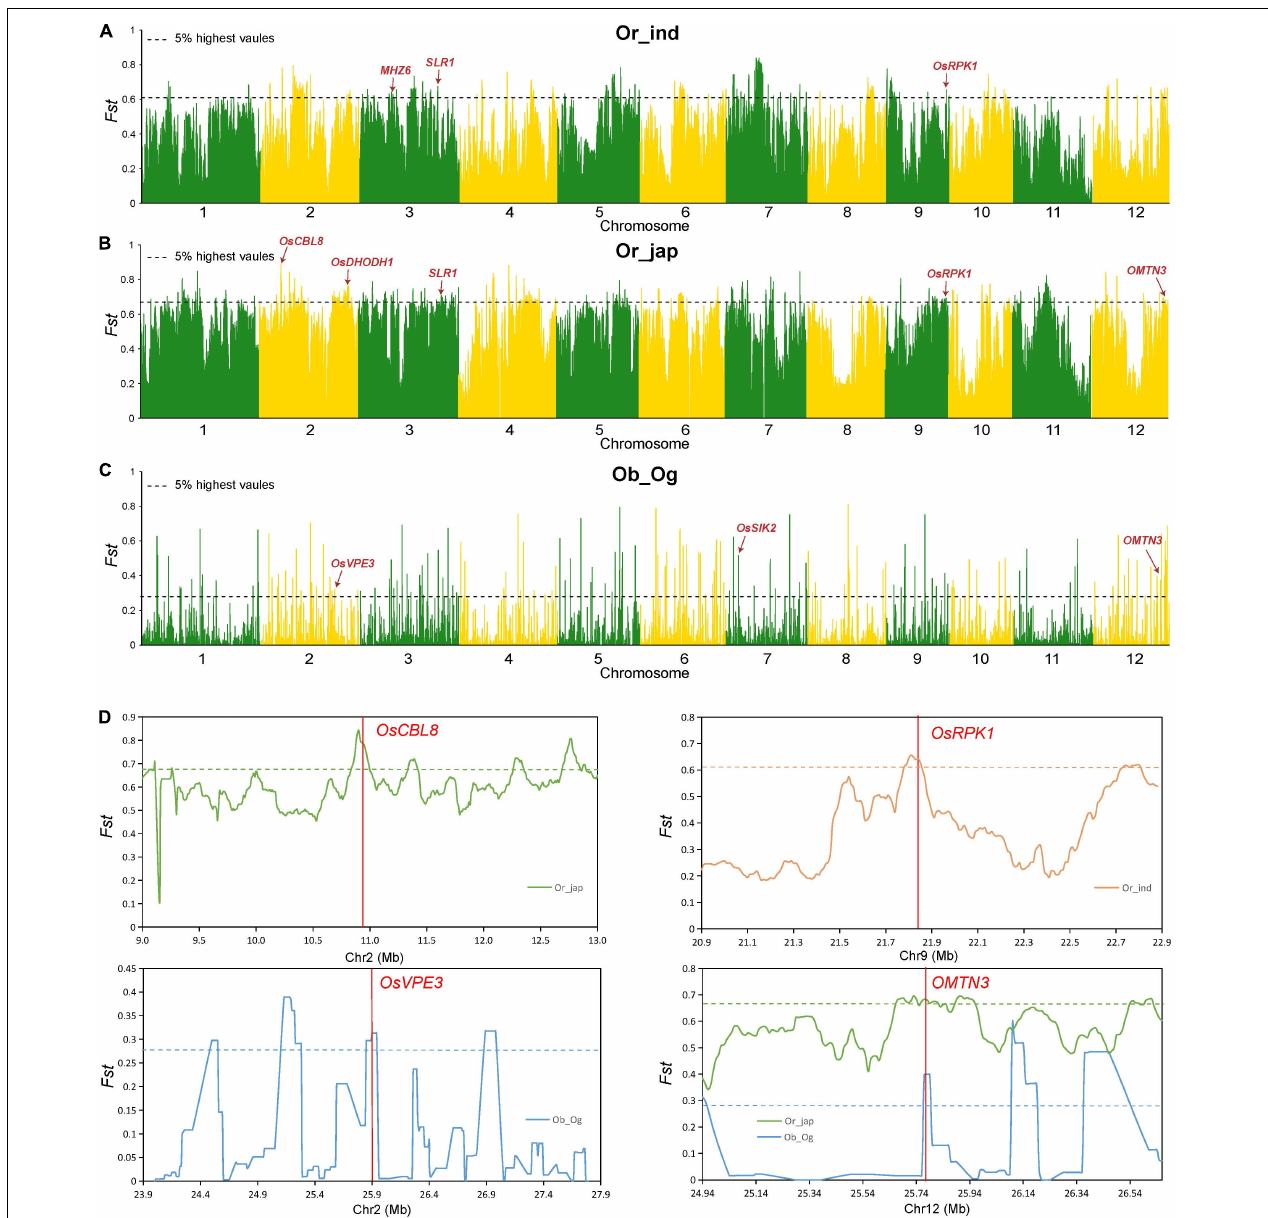
FIGURE 5 | Genomic differentiation statistics. (A–C) Genomic differentiation between O. rufipogon and indica (ind) (A) ; O. rufipogon (Or) and japonica (jap) (B) ; and O. barthii (Ob) and O. glaberrima (Og) (C) . Red arrows indicate the divergent regions overlapping with reported salt tolerance genes. (D) Genetic differentiation of several important genes. Green, orange, and blue lines represent the F ST between O. rufipogon and indica , O. rufipogon and japonica , and O. barthii and O. glaberrima , respectively. Horizontal dashed lines correspond to the top 5% threshold. Red vertical lines represent the location of the reported